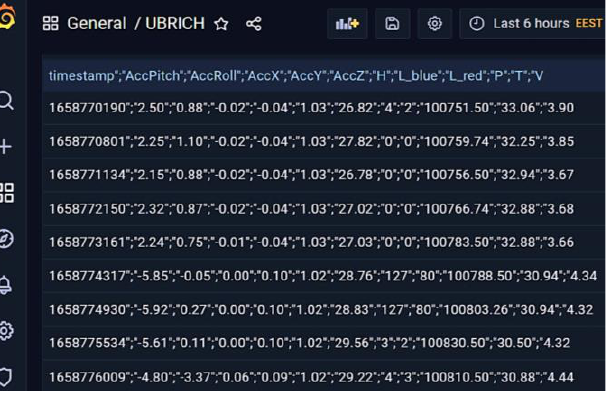
Figure 29. Data visualization in open-source platform Grafana.